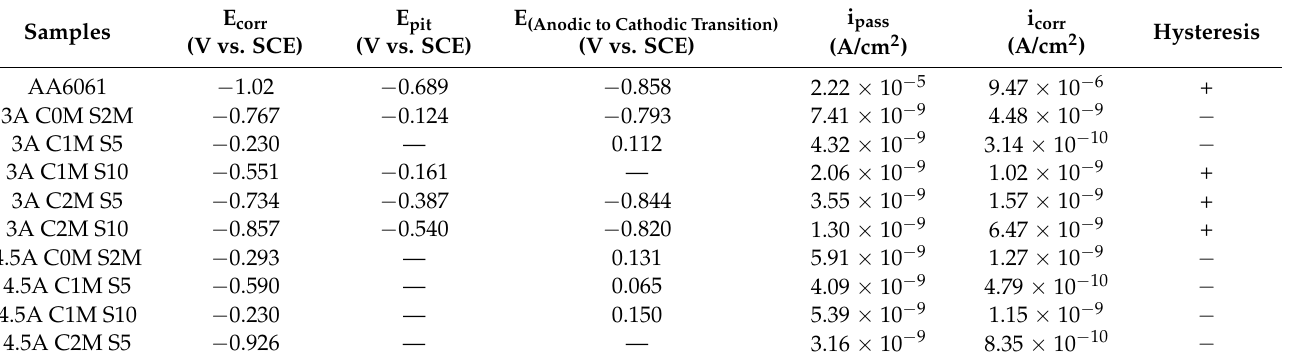
Table 3. CPP parameters of AA6061 samples in NaCl